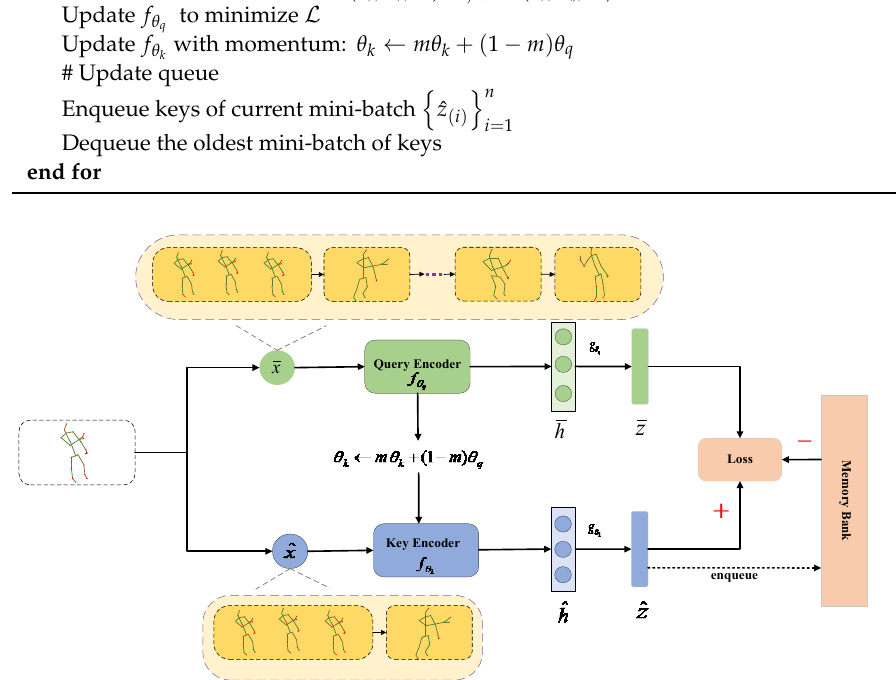
Figure 2. Basic framework based on asymmetric data augmentation strategy.